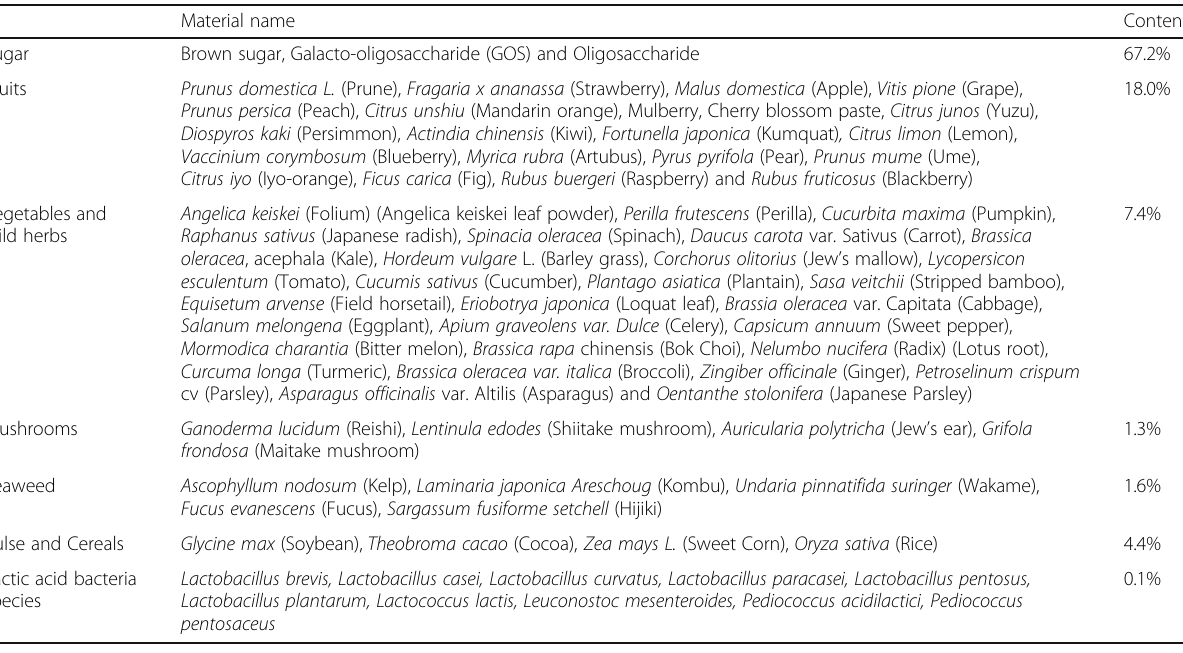
Table 1 Materials of fermented fruits and vegetables, Xeniji